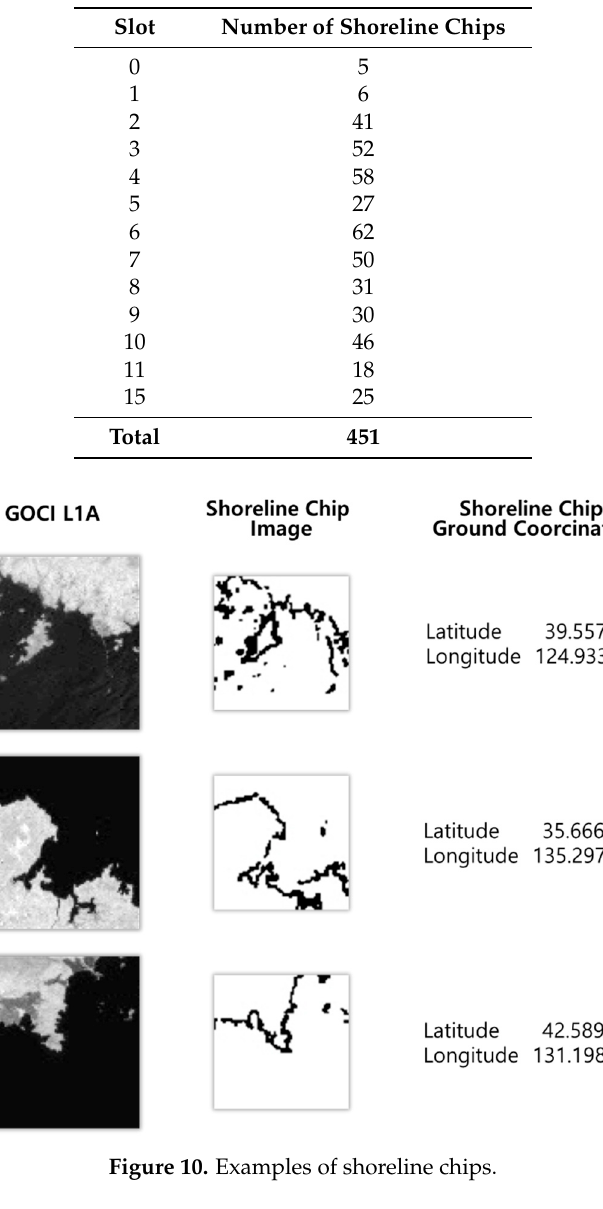
Table 1. Construction of shoreline chips.